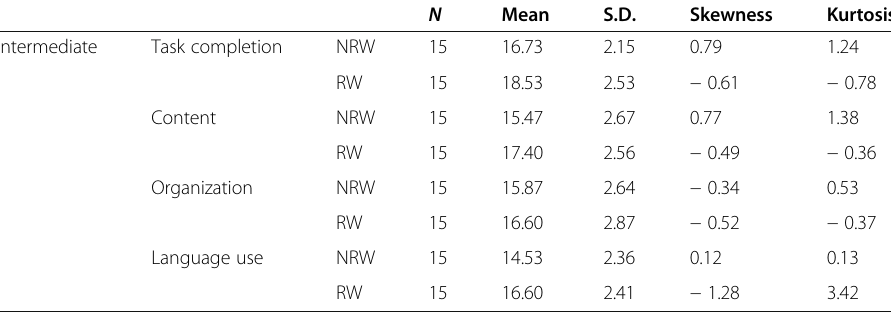
Table 6 Sub-score comparison of the intermediate-proficiency group